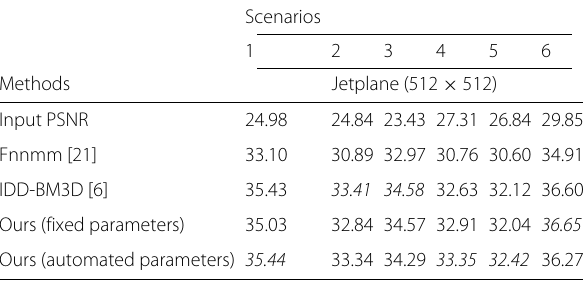
Table 4 PSNR of the three methods in six